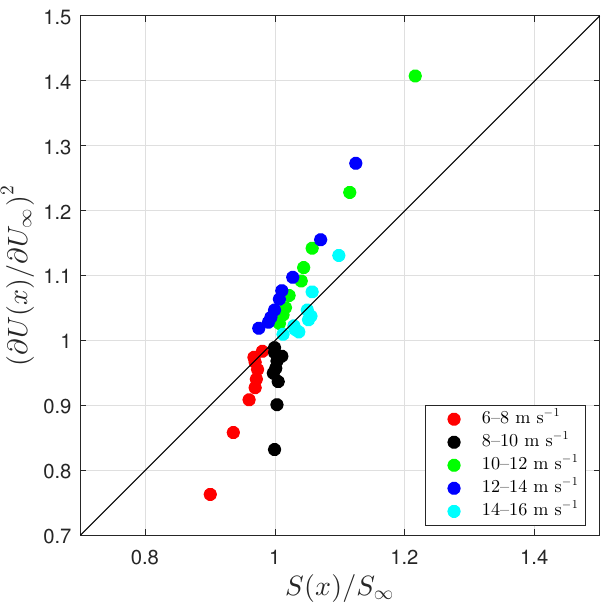
Figure 5. Change in low-frequency ( f < 0 . 007Hz) spectral power of the longitudinal velocity component measured by the lidar com- pared to ( ∂U ( x ) /∂U ∞ ) 2 . The different points for a given wind speed interval correspond to different distances from the rotor x